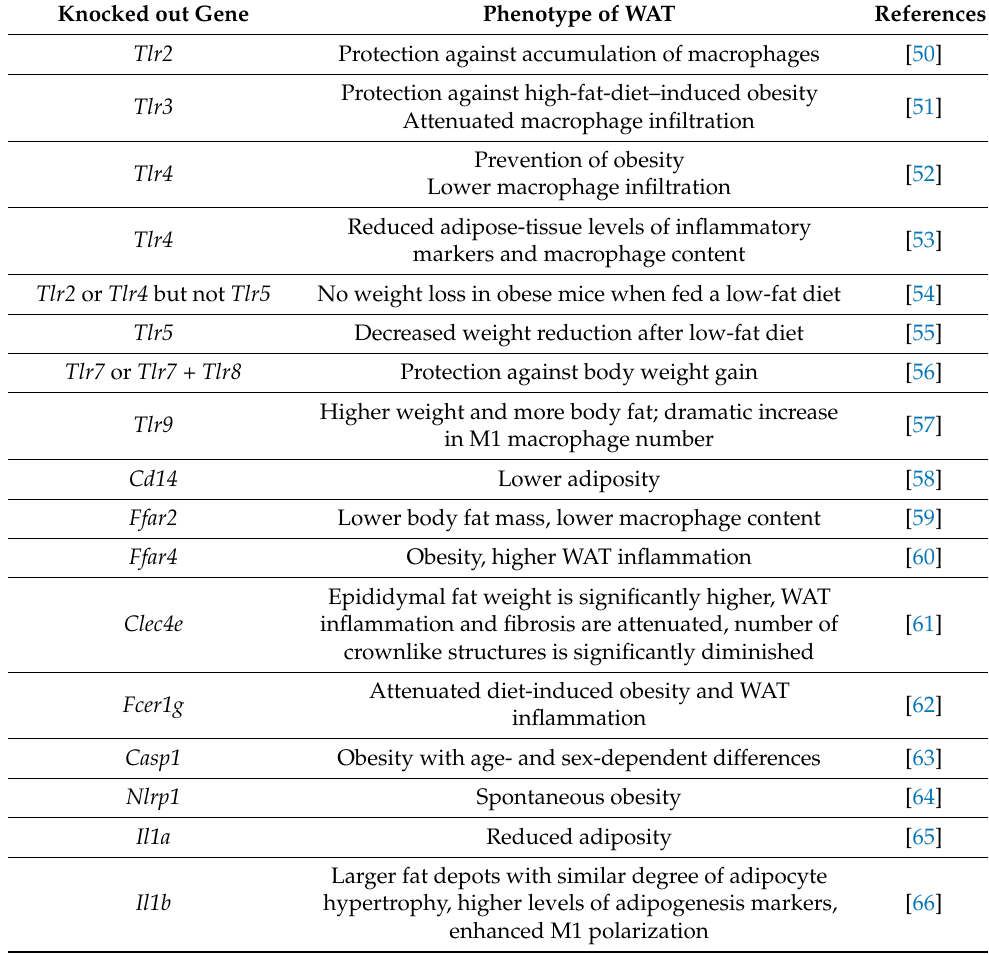
Table 1. Knocked out innate-immunity genes and corresponding WAT phenotypes in model animals (mice, unless indicated